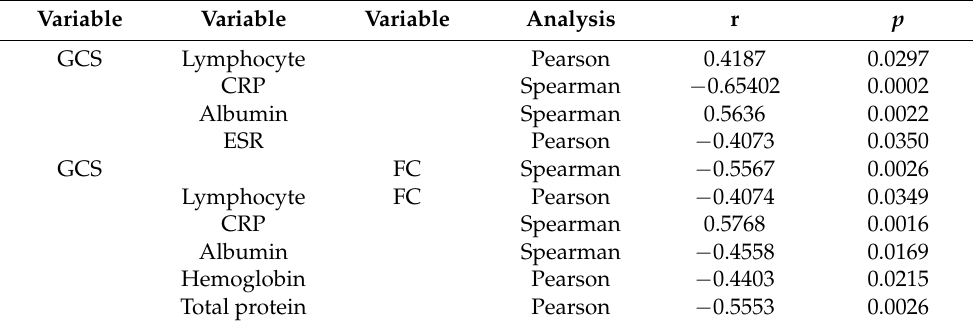
Table 5. Correlations among FC, GCS, and blood variables in stroke